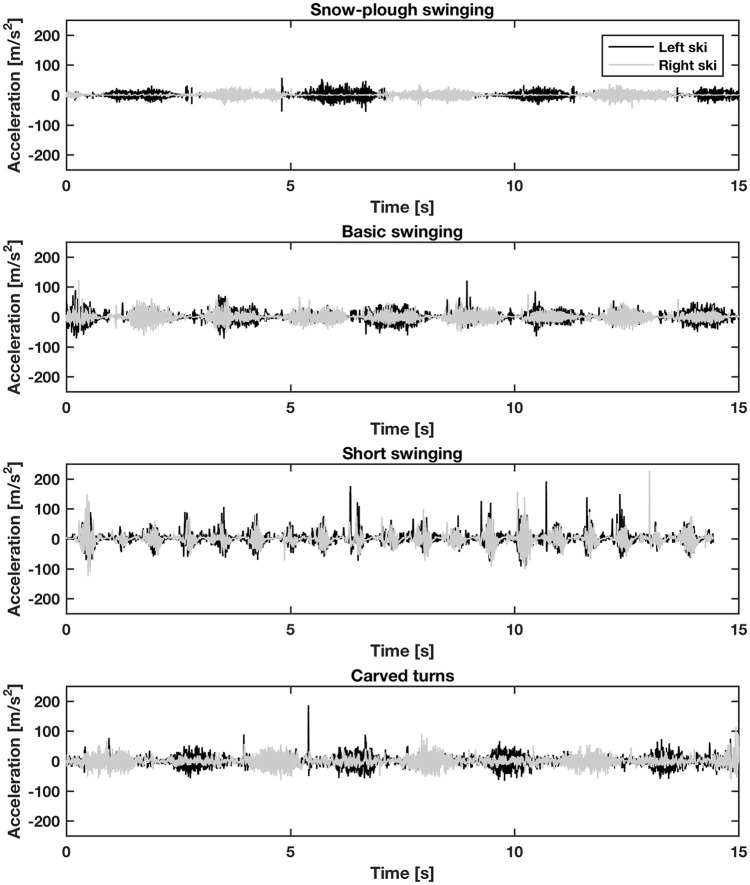
Representative time-courses of acceleration measured at the left and right ski boot of one skier while performing forms of skiing that involved turning.